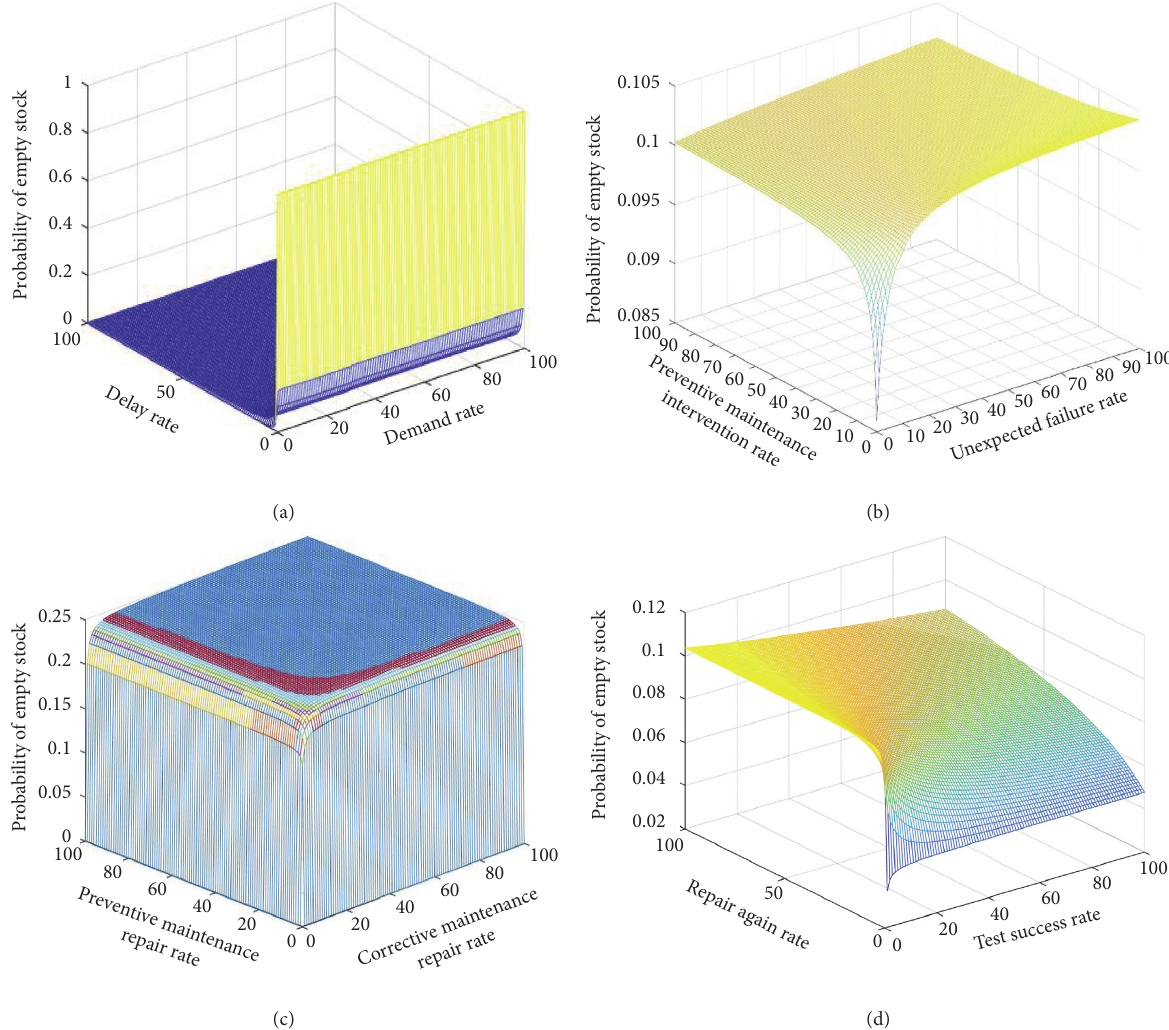
Figure 4: Probability of empty stock. (a) Variation of demand and delay rates. (b) Rate variation of unexpected failure and maintenance interventions. (c) Repair rate variation for corrective and preventive maintenance. (d) Test rate variation (repair again or